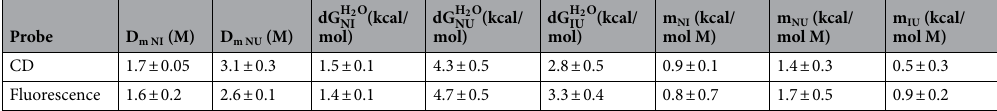
in the intensity and notable red-shift in the λ max , 345 nm to 360 nm, upon increasing GdnHCl concentration from 2.25 to 3.0 M with no apparent changes further. This redshift in λ max showed Trp residues exposure to a polar environment as a result of complete unfolding of AAR at higher GdnHCl concentration. The unfolding transition curve was fitted into the three-state transition model (Eq. 11), and the D m (NI) and Dm (NU) were determined to be 1.6 ± 0.2 M and 2.6 ± 0.1 M, respectively (Table 3). Apparent standard free energy of unfolding of the transitions from native to intermediate dG H 2 O NI , intermediate to unfolded dG H 2 O IU , and native to unfolded (Table 3). The results obtained were in agreement with the CD data showing that AAR follows a 3-state GdnHCl –mediated unfolding transition via intermediate formation. From the theoretical curves, the apparent fraction of native (f N ), intermediate (f I ) and unfolded (f U ) protein with respect to denaturant concentration were calculated by using Eq. 9 (Fig. 8E). The maximum fractional population (~ 60%) of intermediate state for the protein was observed at 2.25 M GdnHCl concentration.